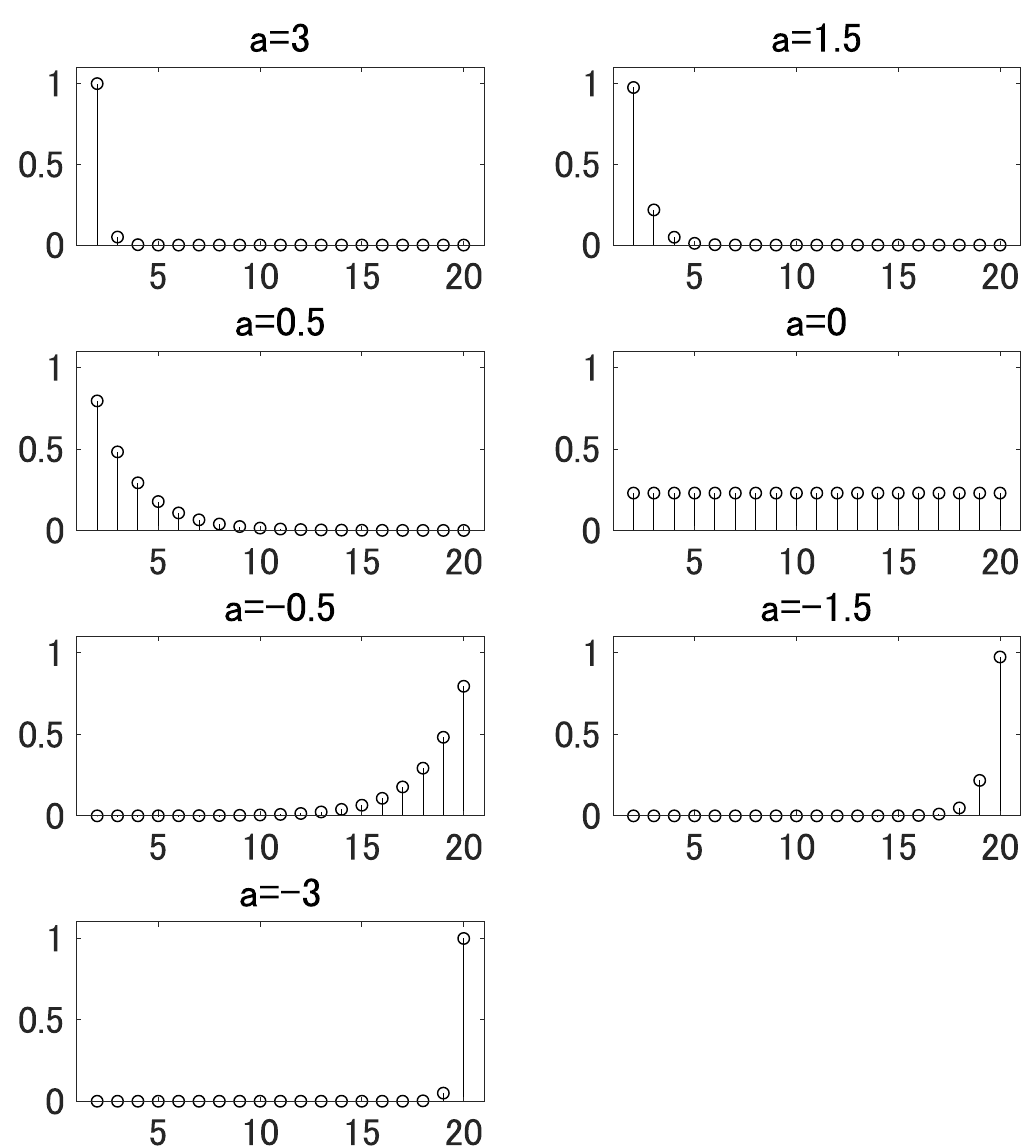
Figure 2. ζ 2 , . . . , ζ n in (44) for n = 20 and a = 3,1.5,0.5,0, − 0.5, − 1.5, −